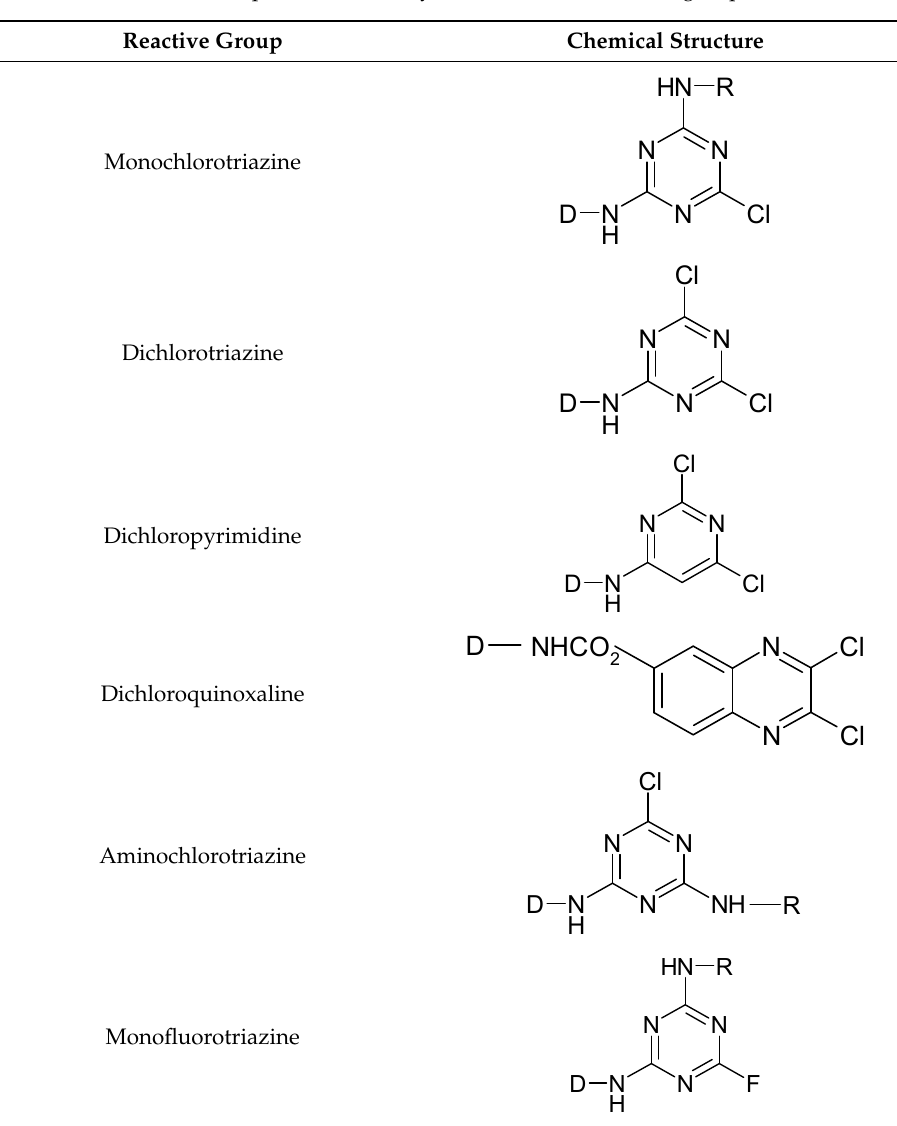
Table 1. Examples of reactive dyes with different reactive groups.